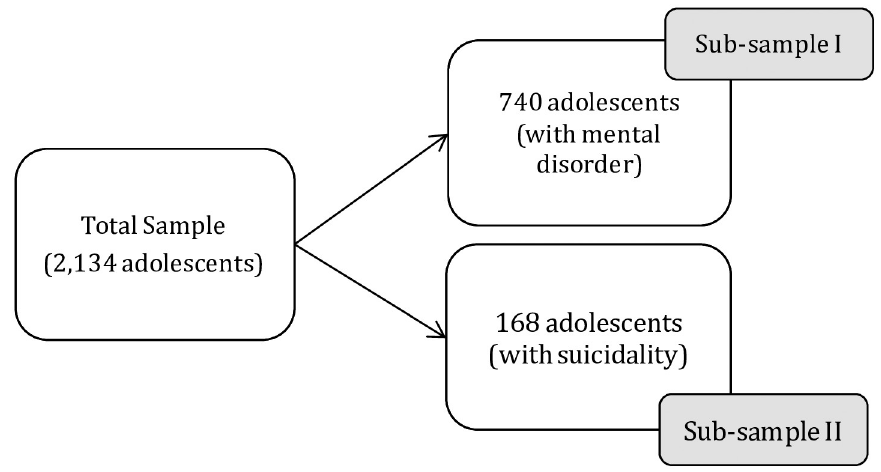
Fig 1. Flow-chart of selecting sample and sub-sample population for the